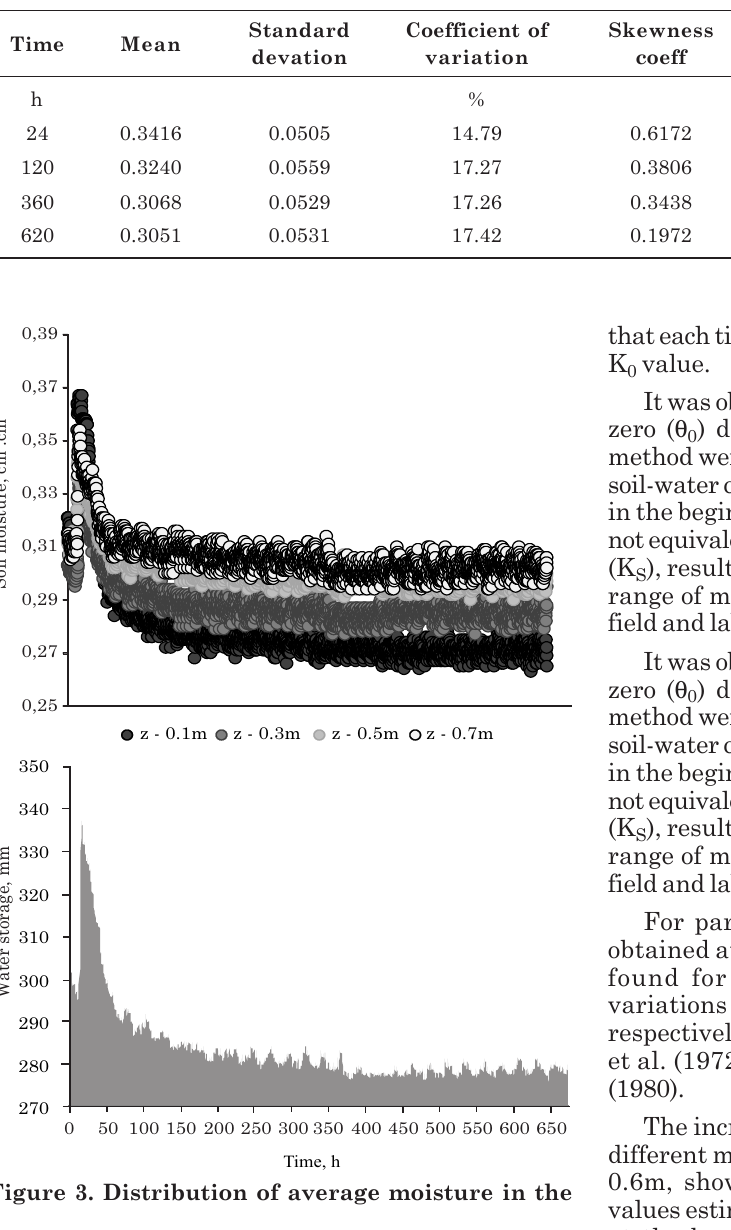
Table 3. Setting parameters of the function K( θθθθθ ) obtained by the van Genuchten(1980) approach